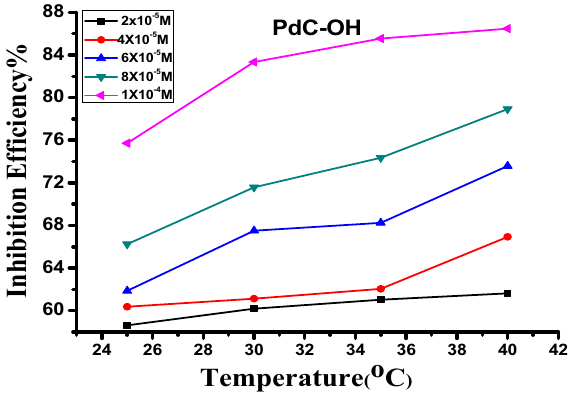
Figure 5. Difference of %η against different solution temperatures for compound PdC-OH.